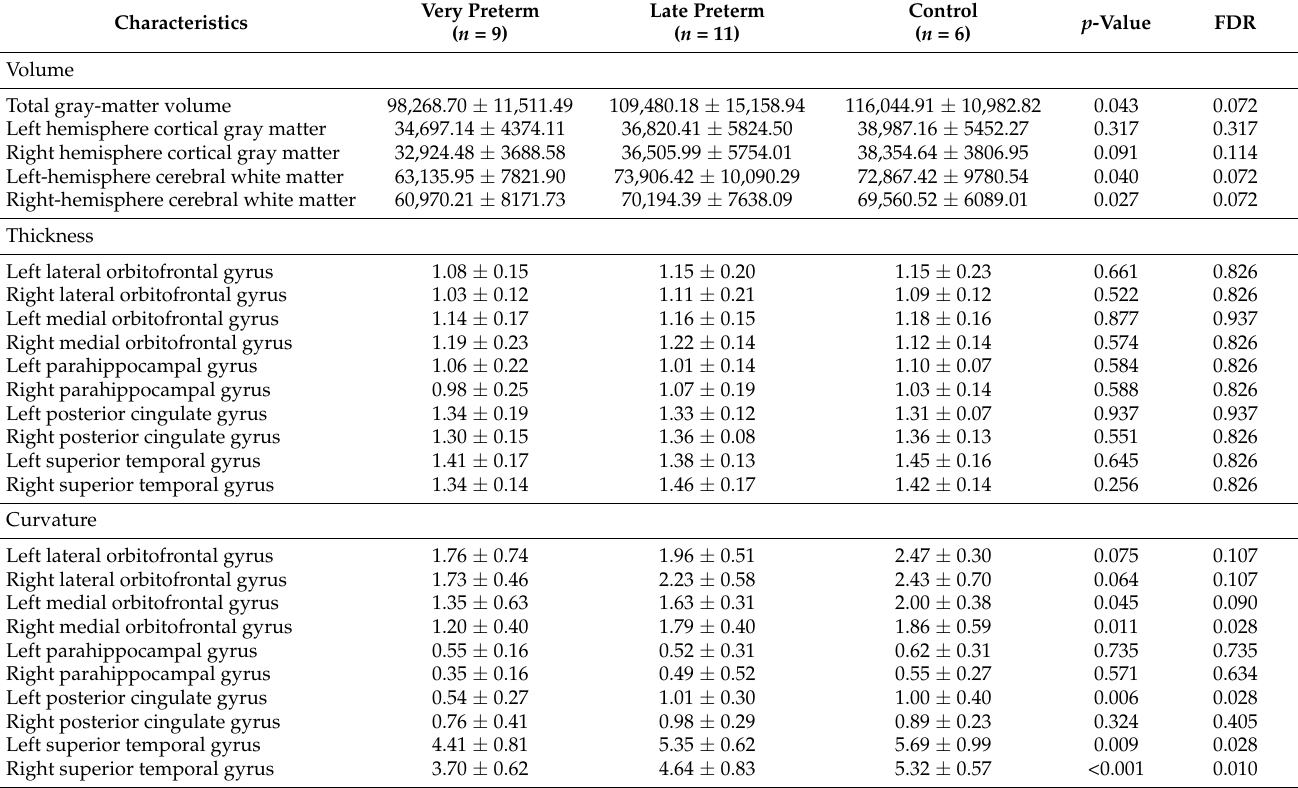
Table 3. Brain differences between preterm and control